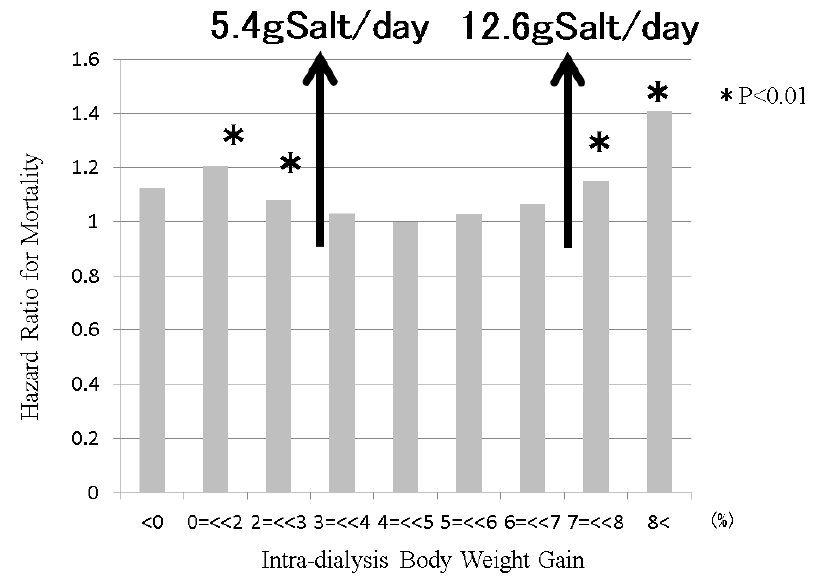
Figure 8. The relationship between intradialysis body weight gain and mortality in dialysis patients. Sodium intake is balanced with water intake via the thirst center. Sodium removal is balanced with water removal during dialysis session. Therefore, intradialysis salt intake can be estimated from intradialysis body weight gain. The Japanese Society of Dialysis Therapy reported the relationship between intradialysis body weight gain and mortality at 1 year as surveillance of dialysis patients by the Japan Society of Dialysis Therapy 2009.12.31. From 3% to 7% of intradialysis body weight gain, the mortality of dialysis patients remained good. From estimations from this intradialysis body weight gain, dialysis patients can maintain good conditions from 5.4 g salt/day (=2.1 g sodium/day) intake to 12.6 g salt/day (=5.0 g sodium/day) intake, if the body weight of the dialysis patient is 60 kg.